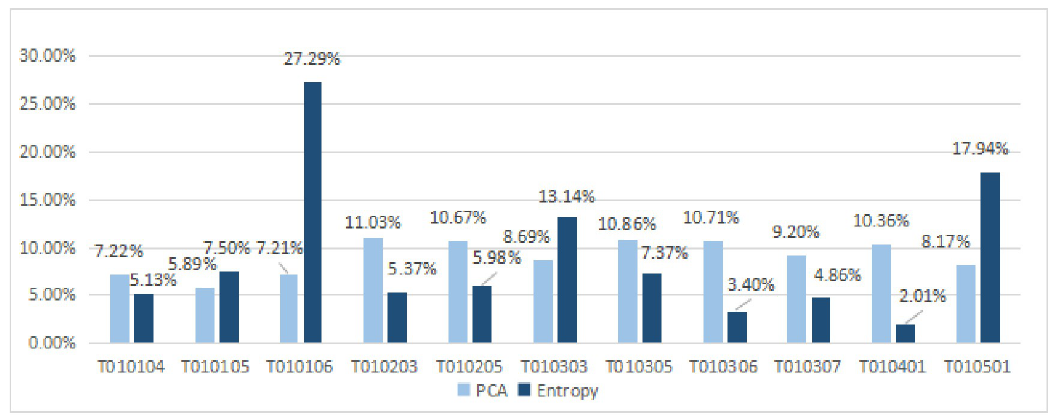
Fig 6. The computed outcomes of weights in Case Study 2.